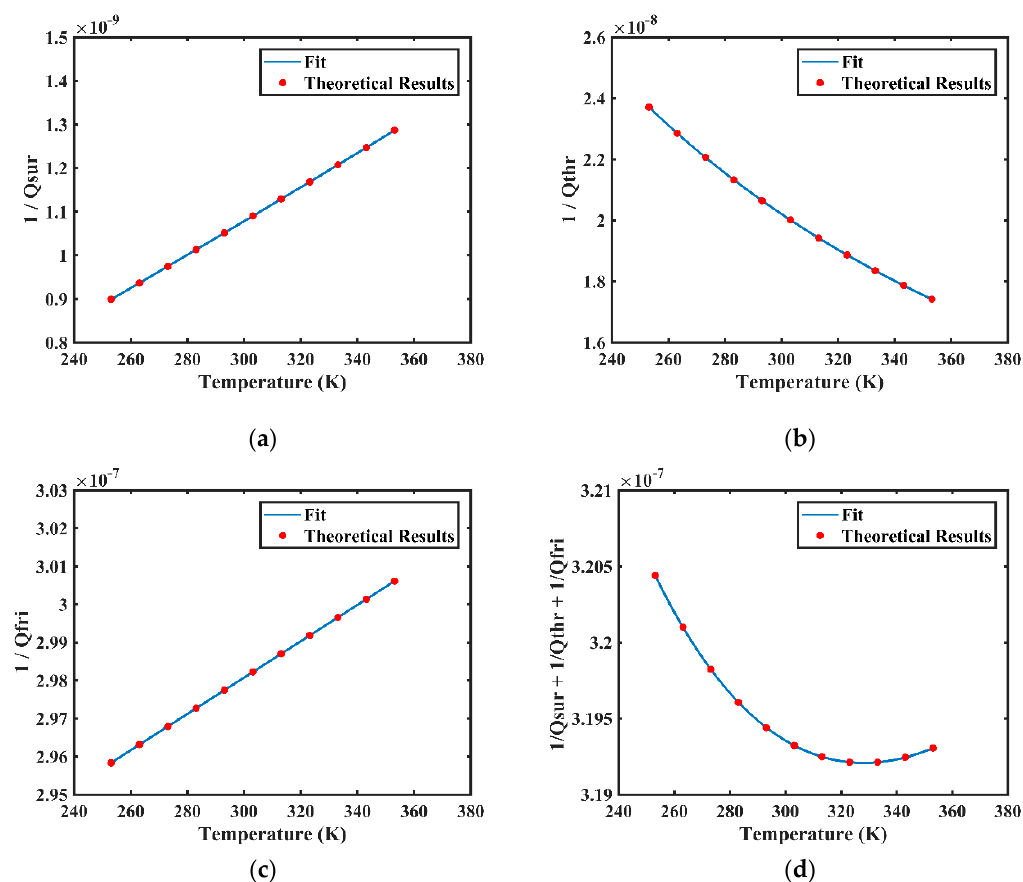
Figure 5. Numerical calculations of di ff erent types of damping loss varying with temperature at the temperature range from 253.15 K to 353.15 K: ( a ) the surface-loss correlated 1 / Q sur varies with temperature; ( b ) the thermoelastic-damping correlated 1 / Q thr varies with temperature; ( c ) the internal-friction correlated 1 / Q fri varies with temperature; ( d ) the sum of 1 / Q sur , 1 / Q thr , and 1 / Q fri varies with temperature.